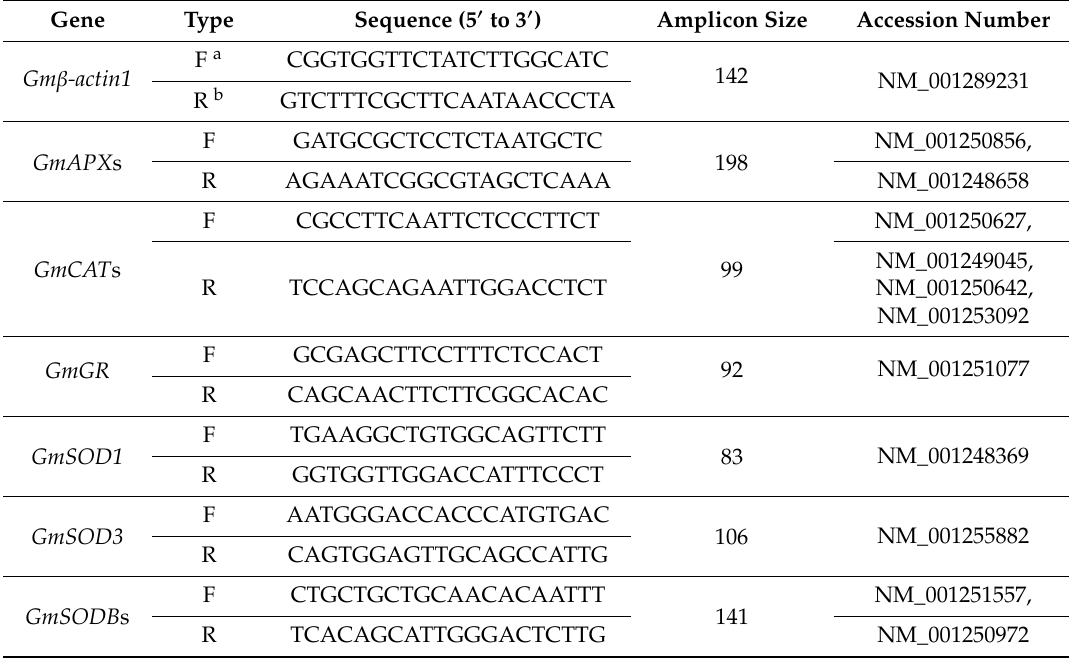
Table 1. Sequences of the primers used for the gene expression